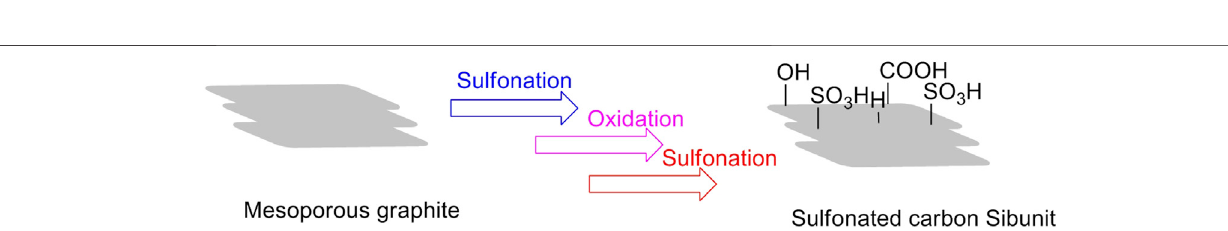
FIGURE 6 | Hydrolysis and dehydration of cellulose promoted by Nb/C-50 as a carbon-based catalyst.